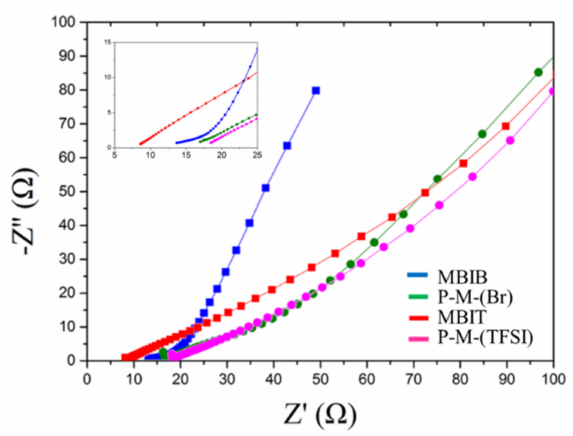
Figure 7. Nyquist plots of IL and PIL-IL blend-based